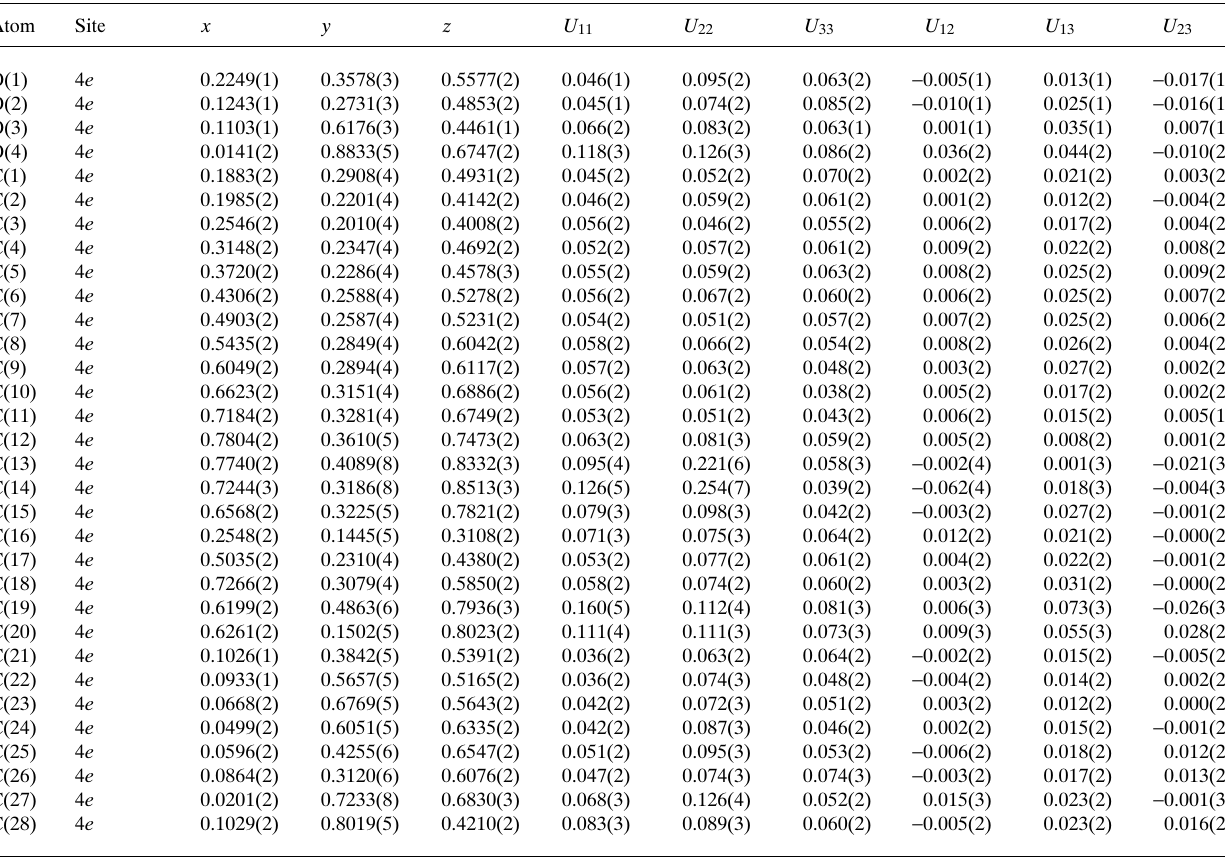
Table 3. Atomic coordinates and displacement parameters (in Å 2 ) .